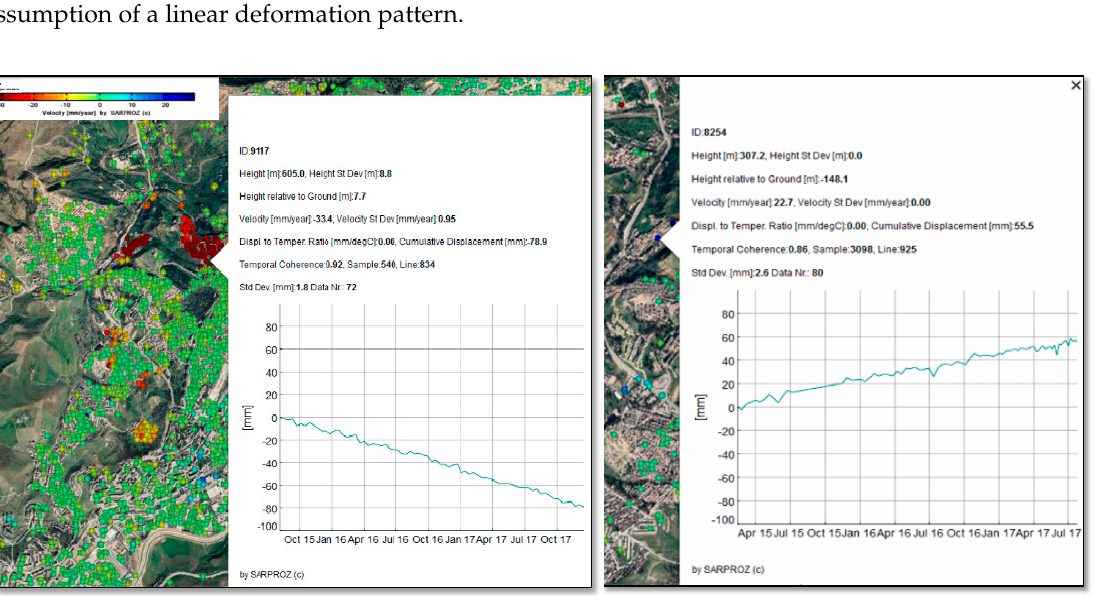
Figure 8. Displacement time series of two points near St Jean. Left: track number 66; right: track number 161.